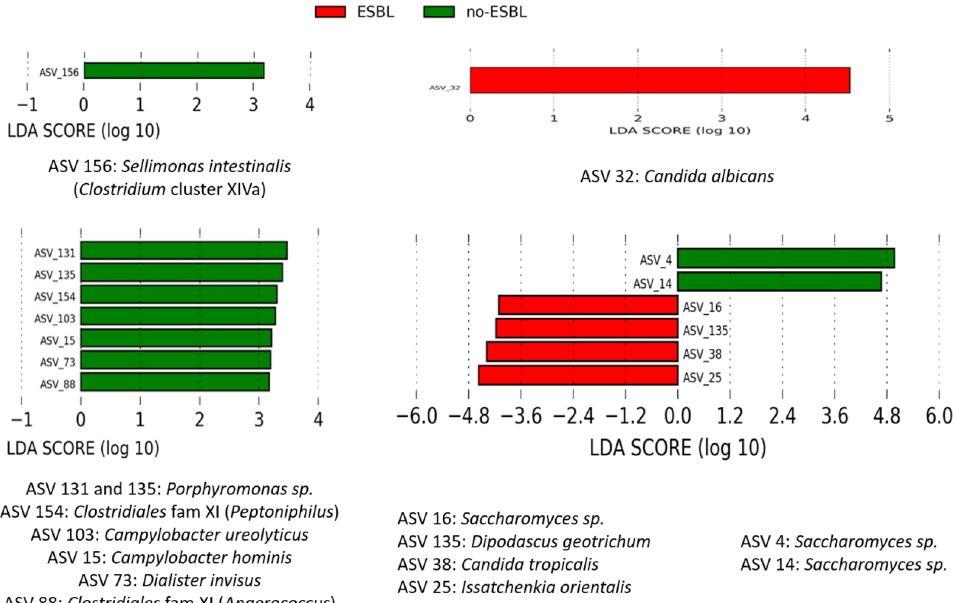
Fig. 3 Comparison of bacterial and fungal species abundances between critically ill ESBL-E fecal carriers and matched non ESBL-E faecal carriers. A . Bacterial species abundances between ESBL-producing E. coli fecal carriers and matched non ESBL-E faecal carriers. B . Fungal species abundances between ESBL-producing E. coli fecal carriers and matched non ESBL-E faecal carriers. C . Bacterial species abundances between ESBL-producing K. pneumoniae fecal carriers and matched non ESBL-E faecal carriers. D . Fungal species abundances between ESBL-producing K. pneumoniae fecal carriers and matched non ESBL-E faecal carriers LefSe analysis with linear discriminant analysis (LDA). Threshold for statistical significance: LDA > 3log. ASV: amplicon sequence